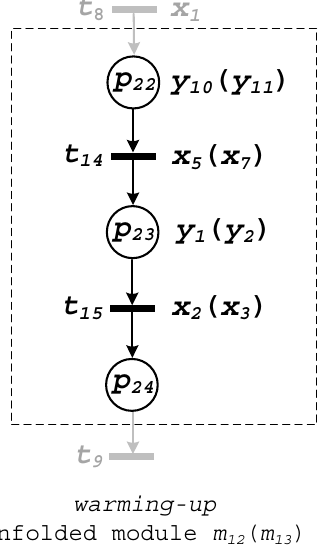
Figure 7. Unfolded module m 12 (m 13 ).